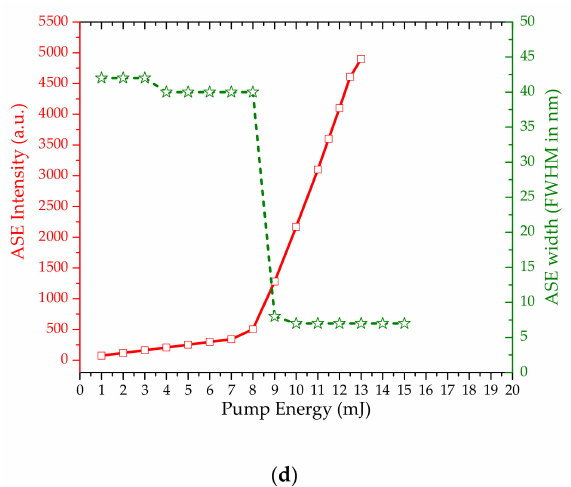
Figure 5. ( a ) Laser-induced fluorescence (LIF) (black dotted-line) at pump energy of 6 mJ, amplified spontaneous emission (ASE) (green dashed line) at pump energy of 11 mJ (threshold), and ASE (blue line) at pump energy of 14 mJ, for 10 µ M TCP in benzene at 20 ◦ C. ( b ) Plot between pump energy and output LIF intensity for same solution at 20 ◦ C. ( c ) LIF (black dotted-line) at pump energy of 4 mJ, ASE (green dashed line) at pump energy of 8 mJ (threshold), and ASE (red line) at pump energy of 12 mJ for 10 µ M TCP in benzene at 60 ◦ C. ( d ) Plot between pump energy and output ASE intensity for same solution at 60 ◦